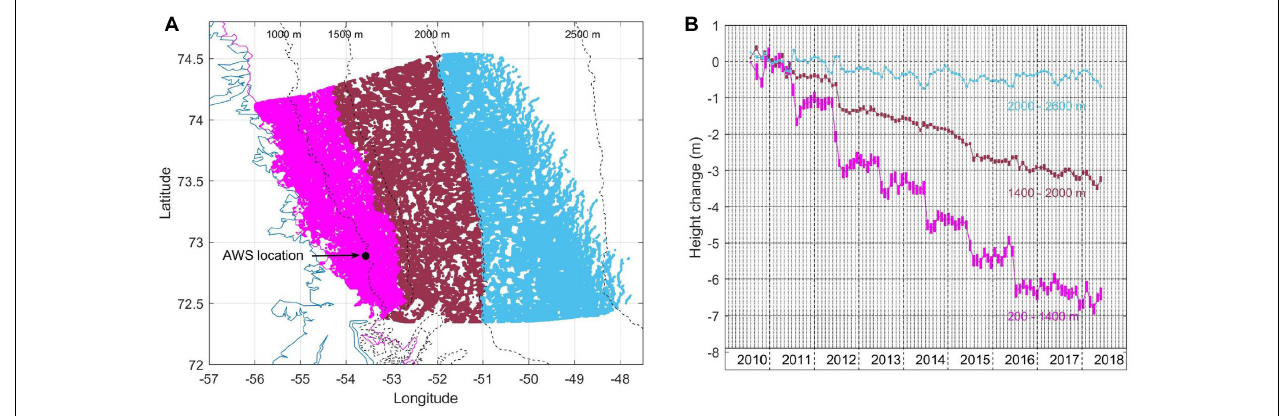
FIGURE 3 | (A) The positions of the CryoSat data from three elevation ranges in NW Greenland (Area 2 in Figure 1 ) are illustrated in color (272,105 samples > 2000 m in blue; 342,119 samples 1400–2000 m in maroon; 169,029 samples 200–1400 m in magenta). The position of the UPE-U AWS is shown by the large black dot. (B) The average temporal height change for the data in the three elevation ranges is shown in B . In this case the temporal CryoSat height change has used 30-day